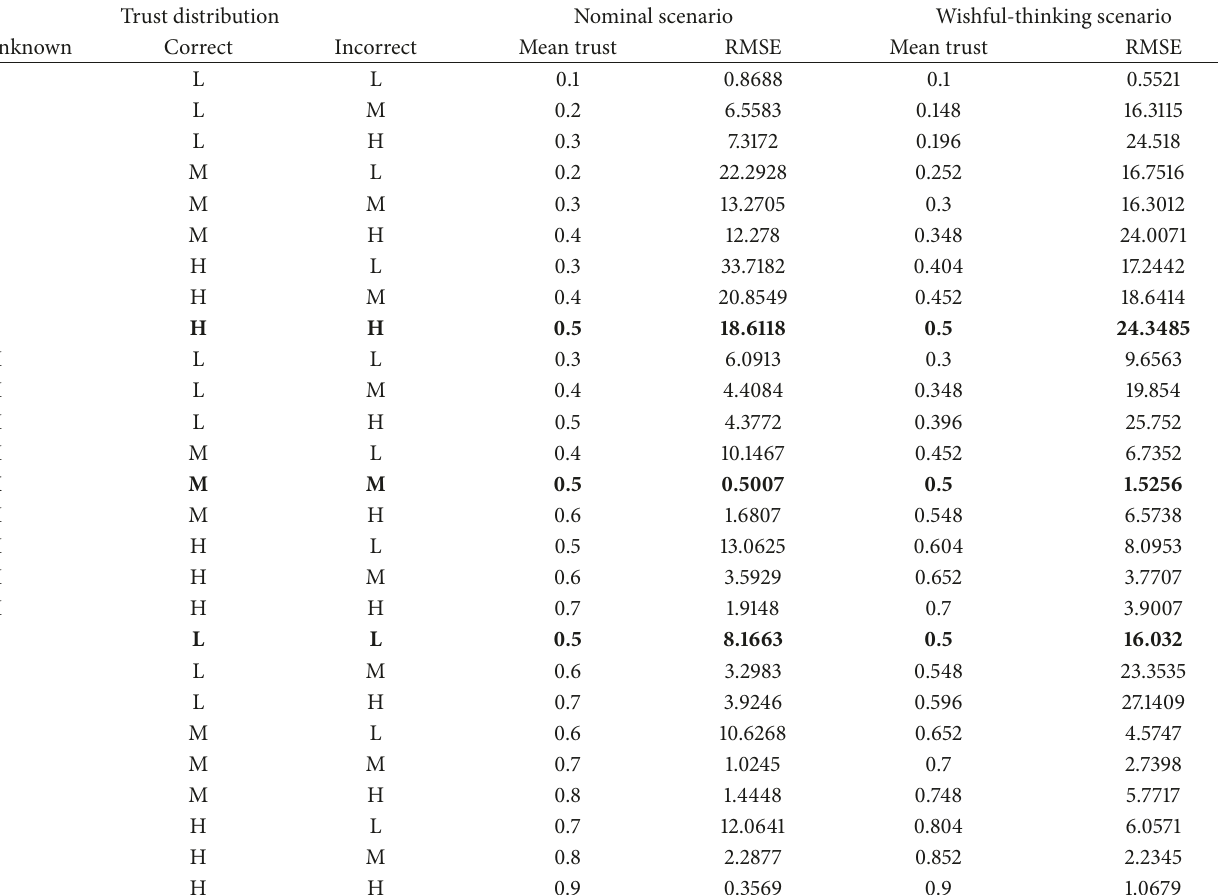
Table 3: RMSE against all configurations for both